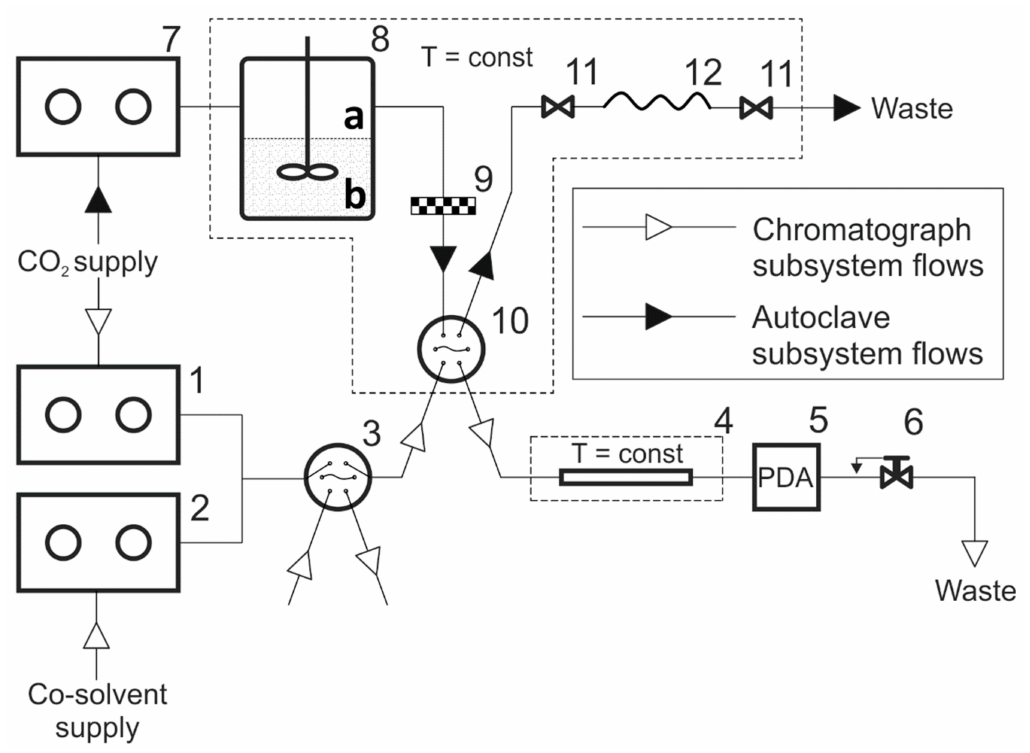
Figure 1. Schematic diagram of autoclave-SFE at-line hyphenation. 1, 7—CO 2 pumps; 2—co-solvent pump; 3—chromatography autosampler loop; 4—thermostated chromatography column; 5—chromatography UV detector; 6—automated back pressure regulator; 8—high pressure autoclave with stirring; 9—filter; 10—6-port two-position injection valve; 11—sampling system shut-off valves; 12–expansion loop; phases in autoclave: a—supercritical CO 2 , b—water-PEG solution